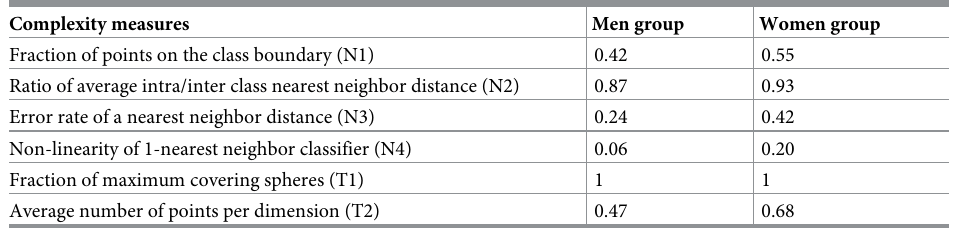
Table 5. Global complexity metrics of 3D knee kinematics according the gender. Complexity measures